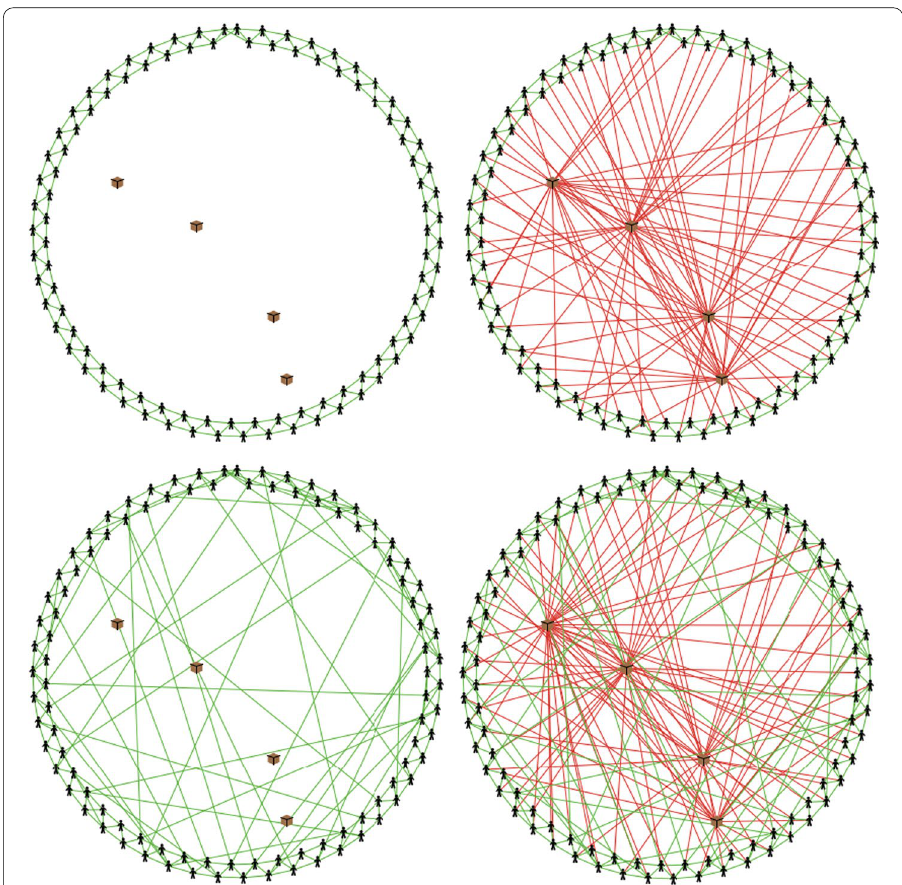
Fig. 1 t = 0 (left) and t = 1 (right) for a network lattice with ρ = 0 (above, clustering coefficient = 0.5 ) and ρ = 1 (below, mean observed clustering coefficient = 0.646 ). n d = 2 , green links represent L c (fixed) and red ones L b (evolving). The green boxes represent each one of the 2 n d